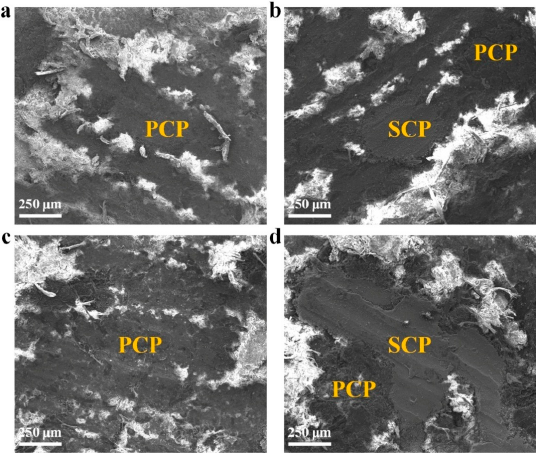
Figure 7. SEM images of the worn surface of the friction composites: ( a ) Bas-0; ( b ) Bas-5; ( c ) Bas-15; and ( d ) Bas-25. PCP indicates primary contact plateaus and SCP indicates secondary contact plateaus.